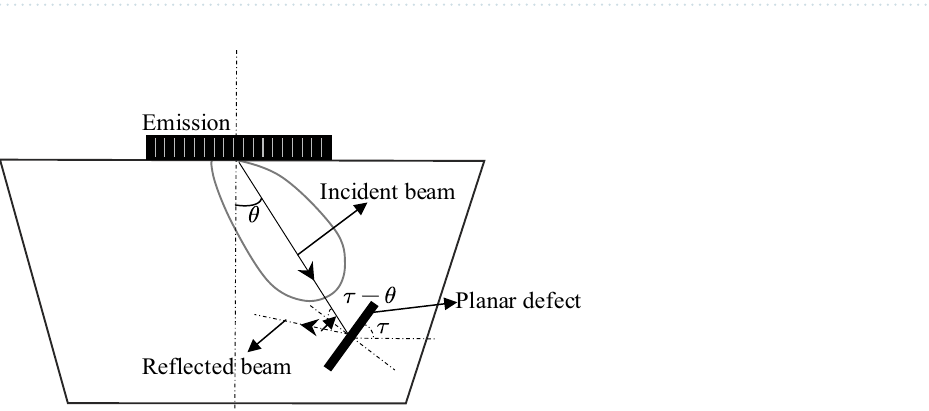
Figure 2. Schematic diagram of the main detection methods currently.